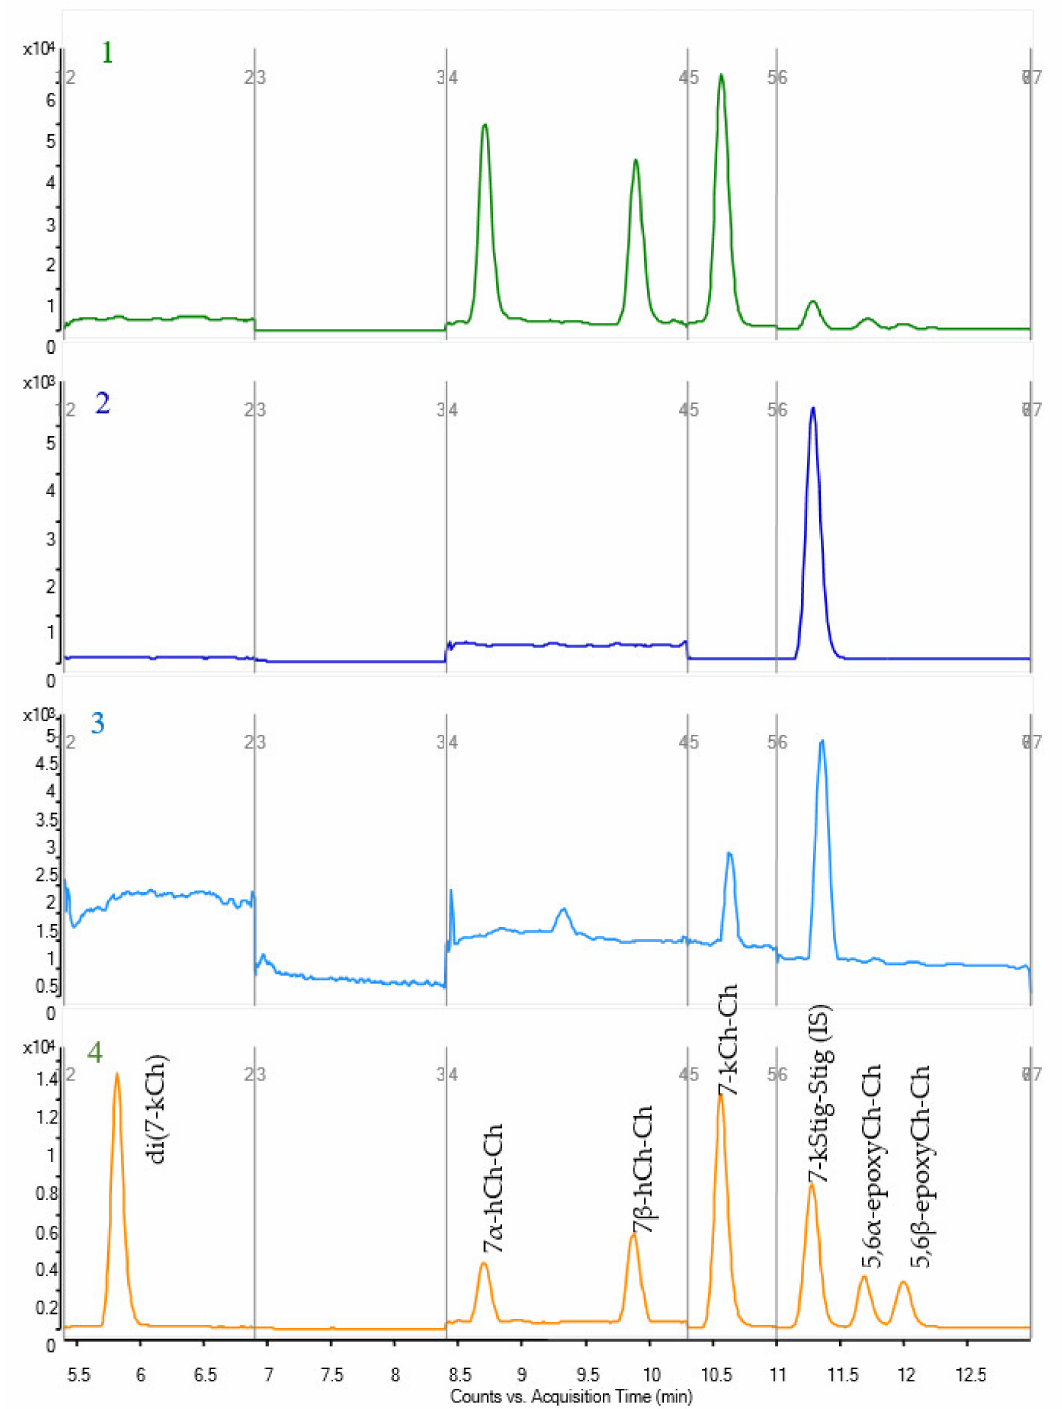
Figure 3. Total ion current (TIC) chromatogram of analysed oxidized 3 β ,3 (cid:48) β -dicholesteryl ethers: ( 1 ) sample after 3 h heating at 200 ◦ C with magnesium, ( 2 ) blank with IS, ( 3 ) butter sample after 3 h heating at 200 ◦ C, and ( 4 ) standard solution of all synthesized oxidized 3 β ,3 (cid:48) β -dicholesteryl ethers at a 100 ng/mL